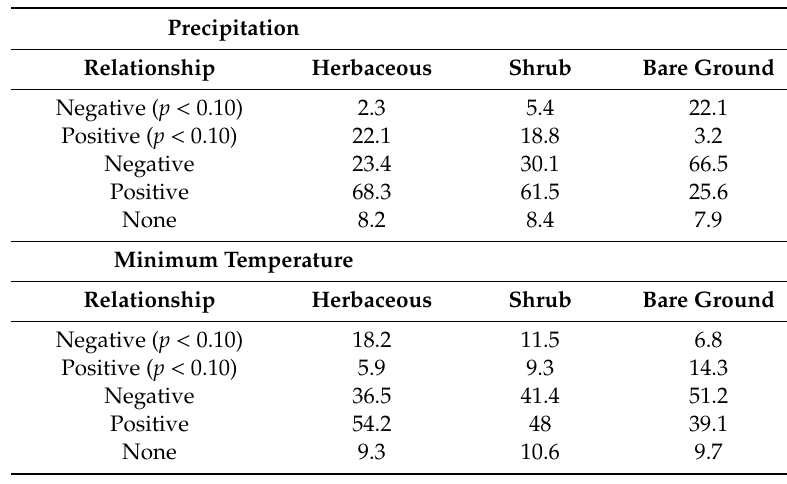
Table 2. Summary of component correlation relationships with climate. Values reflect the proportion (%) of 30-m cells with a given relationship to either precipitation or minimum temperature for each component. Sites with no climate relationship were defined as having correlation between each climate variable and each component with a p value >